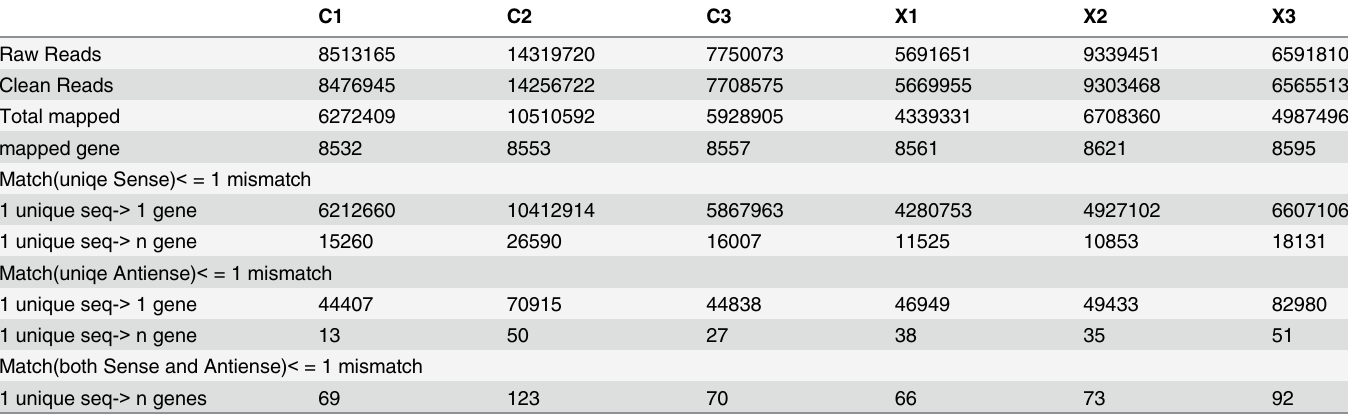
Table 2. Summary of DGE sequences analysis.